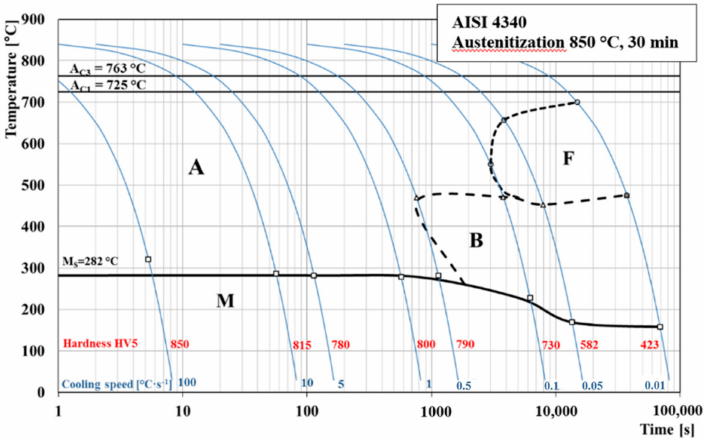
Figure 9. CCT diagram of AISI 4340